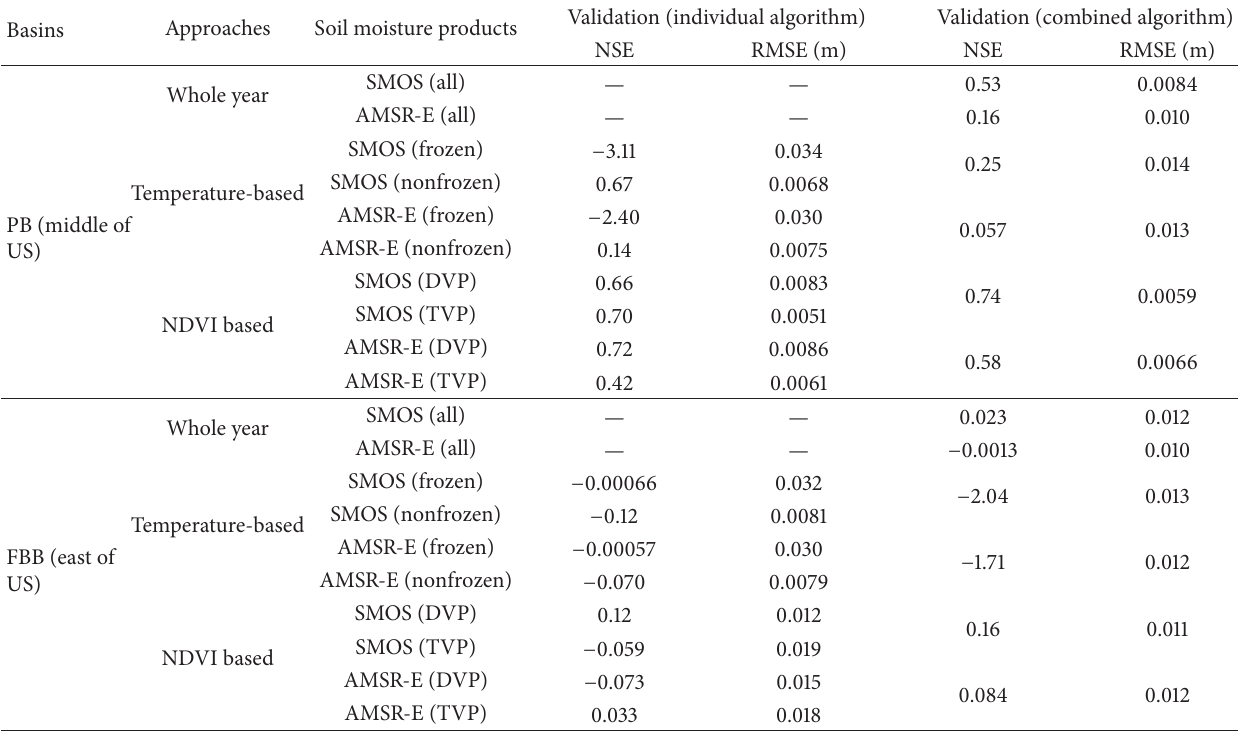
Table 2: Performance statistics of individual algorithm under each approach, as well as the performance of the combined algorithm under each approach. DVP stands for denser vegetation period and TVP means thinner vegetation period.